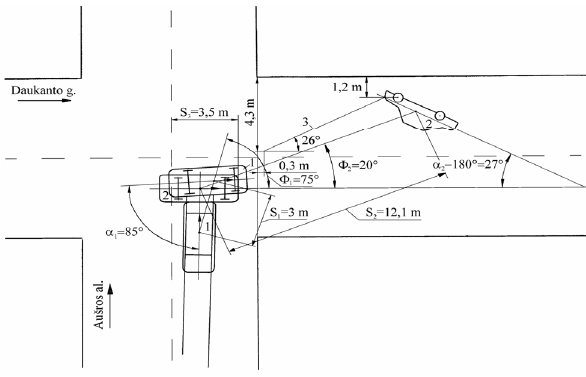
Fig 1. The plan of the place of automobiles collision: 1, 2 are the automobiles; 3 is the mark of sliding of the 2nd automobile